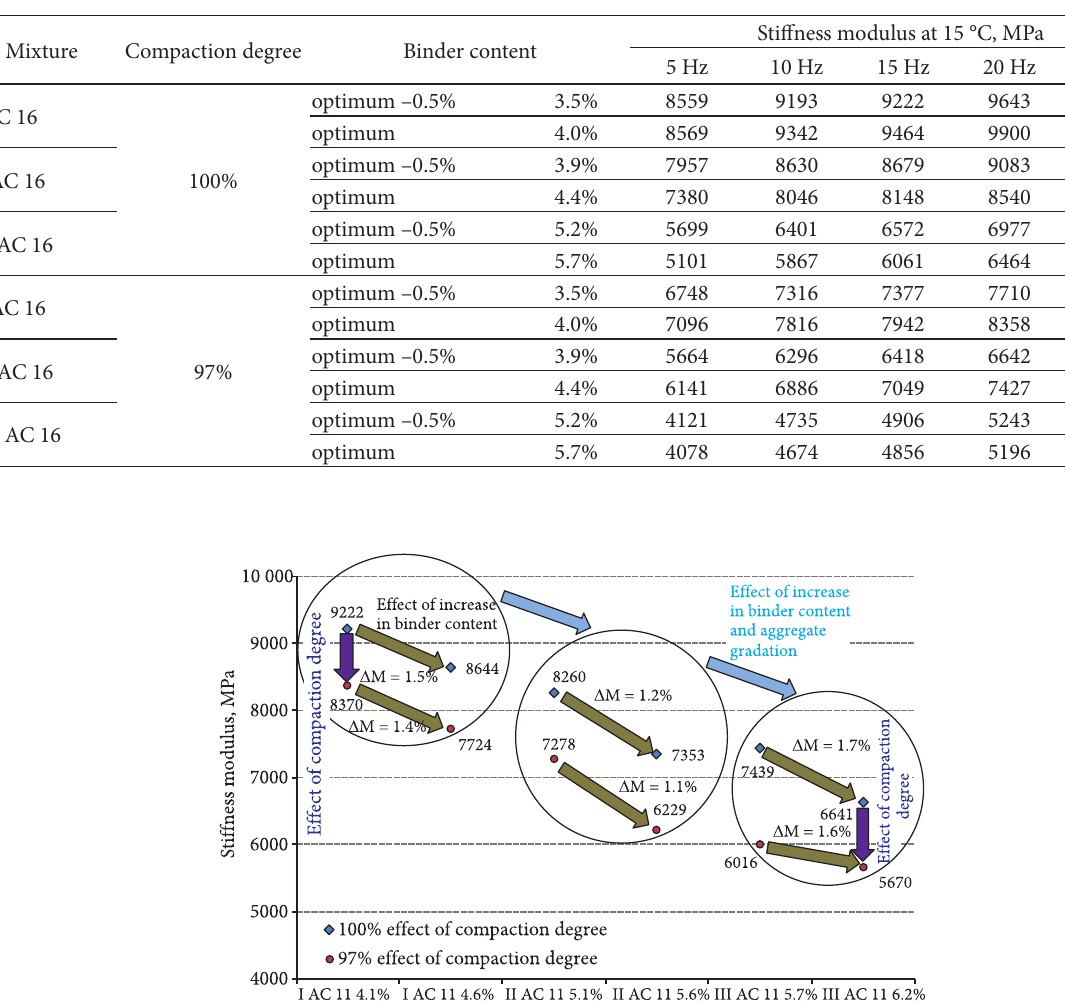
Table 4. Stiffness modulus of AC 16 mixtures